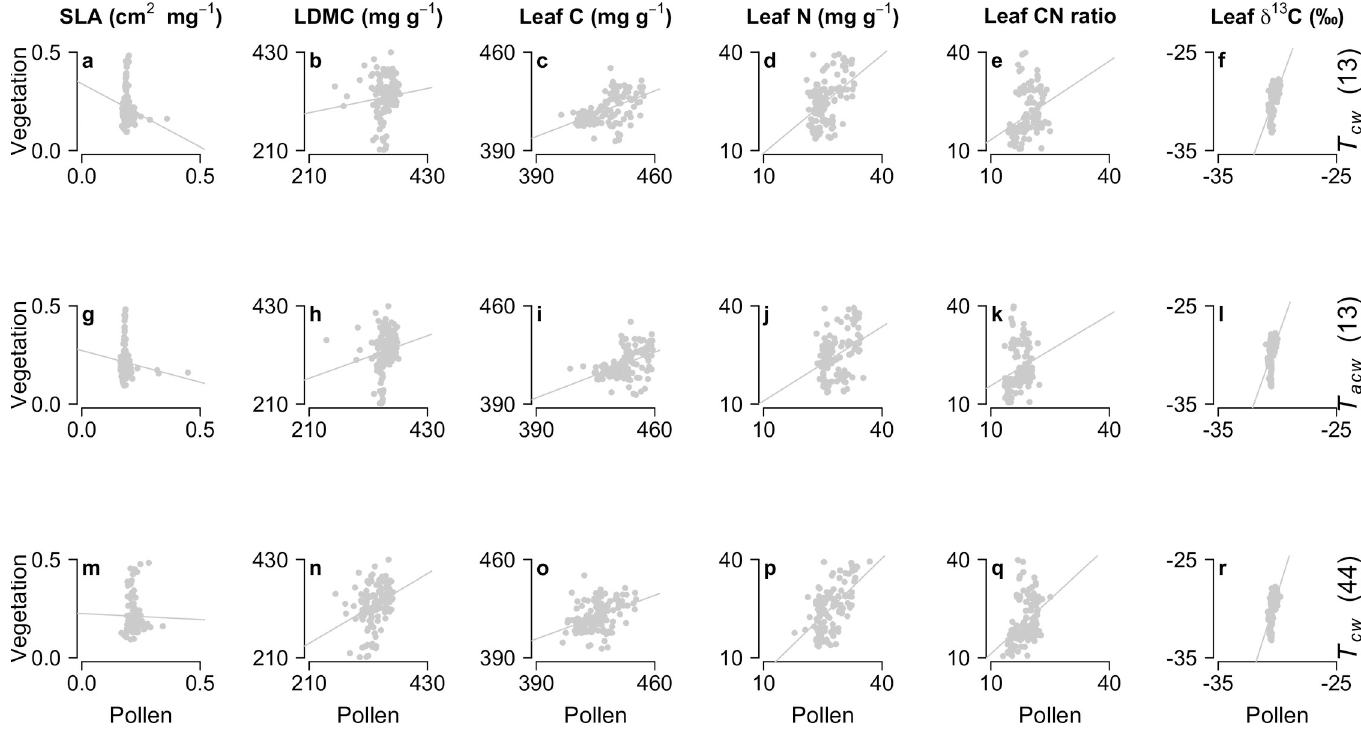
Fig 2. Linear relationships between the CWMs of vegetation and modern pollen before (top row, panels a to f) and after (middle row, panels g to l) relative pollen productivity (RPP) adjustment ( T cw and T acw , respectively) using the 13 pollen types for which RPP estimates were available. The bottom row (panels m to r) shows the relationship between vegetation and modern pollen including all 44 pollen types with and without RPP estimates and with trait data available. Marginal r 2 and RMSEP values of linear mixed effects models (LMEs) of the standing vegetation as a function of the modern pollen data are shown in Table 1. Marginal r 2 and RMSEP were used to determine how well plot-level mean trait data of the modern pollen assemblages can predict mean trait values of the modern fen vegetation.